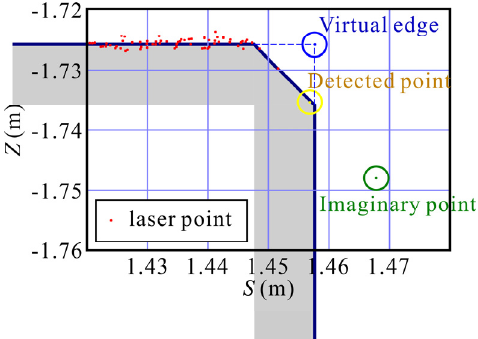
Figure 14. Laser points on the platform of the scan line C